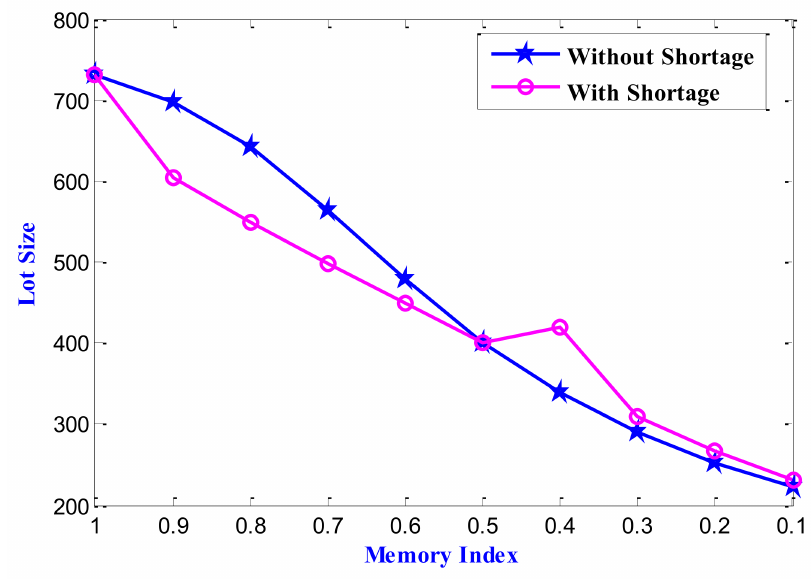
Figure 5. Impact memory on optimum values of the decision variable lot size ( T ∗ ) for the model with and without shortage (from left to right in the horizontal axis memory sense